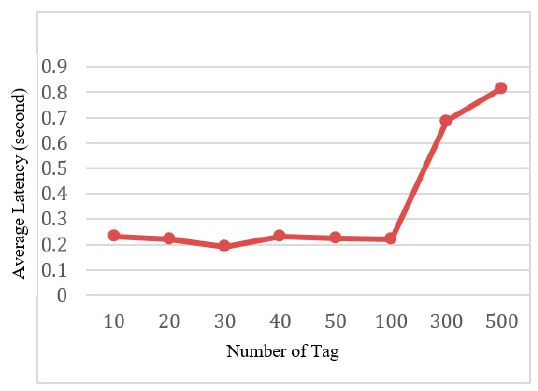
Figure 23. Average latency vs. number of tags.